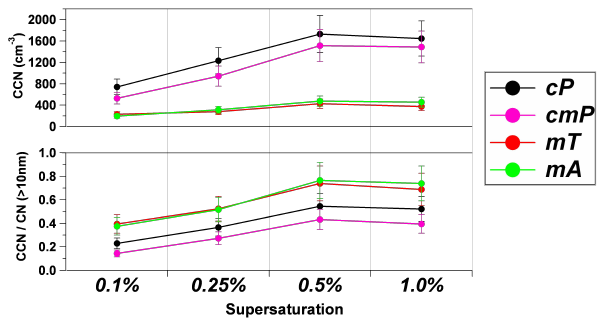
Fig. 14. (Top) CCN concentrations as a function of supersaturation and air mass classification. (Bottom) Ratio of CCN to total Con- densation Nuclei at sizes larger than 10nm